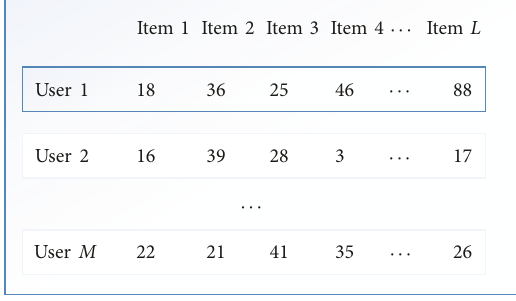
Figure 2: Illustration of chromosome encoding.